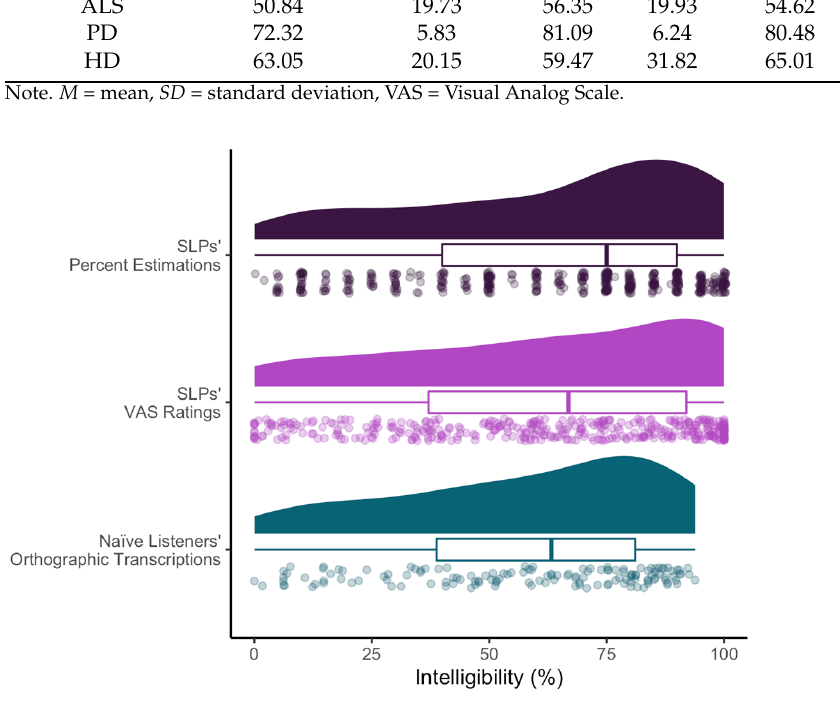
Figure 2. Distribution of Responses for Both the Naïve Listeners’ and SLPs’ Intelligibility Measures. For each of the three ratings investigated in the study, this figure shows the distribution of ratings (top), a box and whisker plot for the ratings (middle), in which the line within the box depicts the median, the left and right ends of the box represent the first and third quartile, respectively, and the left and right “whiskers” depict the smallest and largest rating. Finally, this figure shows the indi- vidual listener ratings across all 20 speakers, as indicated by the semi-transparent data points (bot- tom). Individual data points that appear to be darker signify a high-density region of overlapping responses. SLP = speech-language pathologists, VAS = visual analog scale